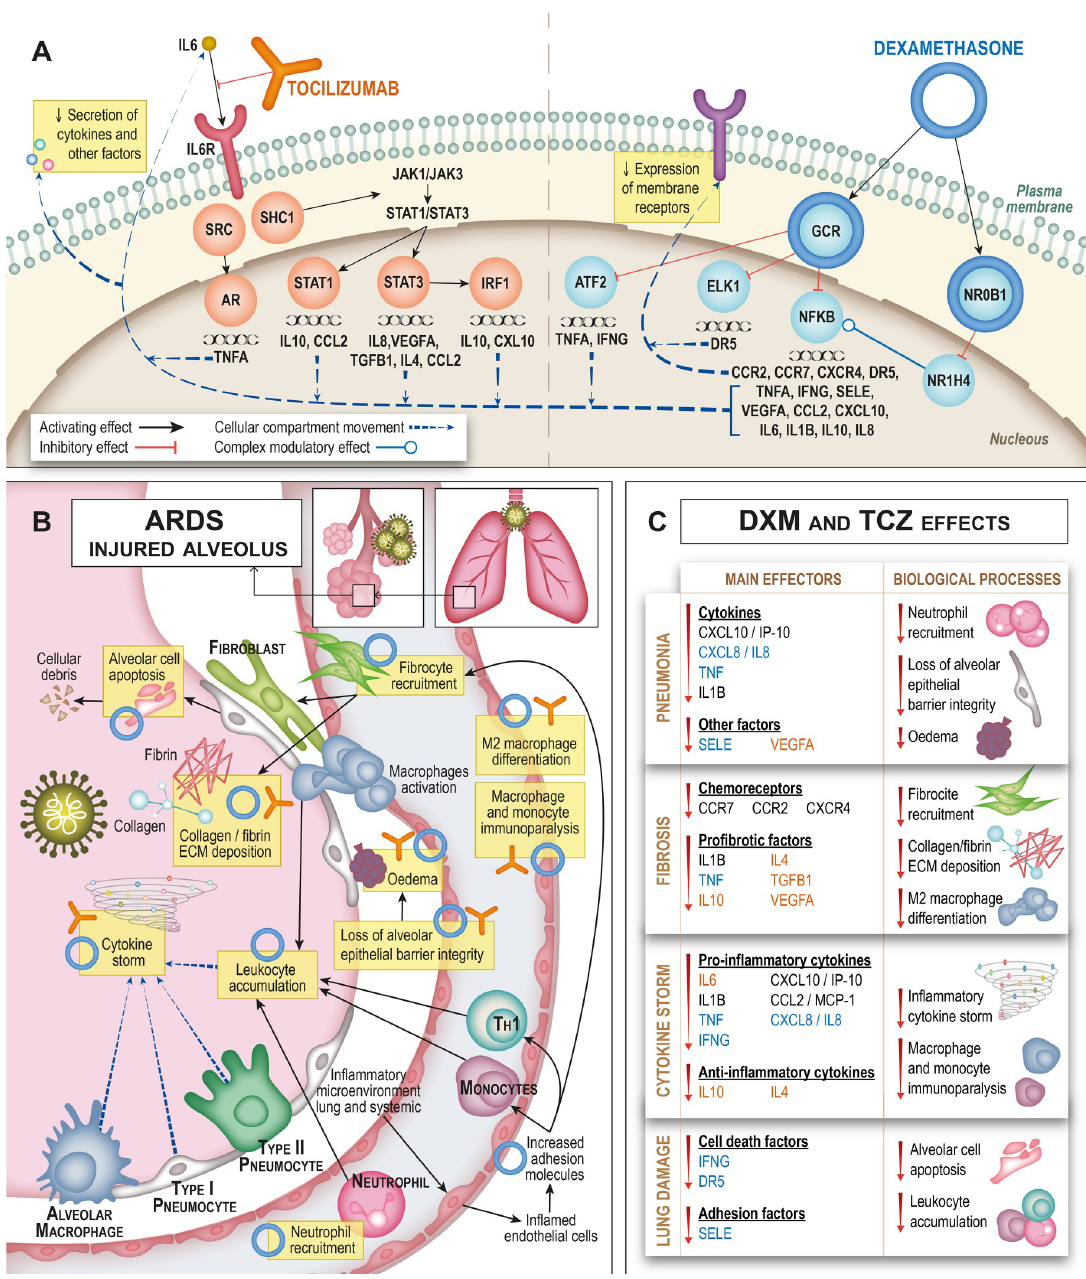
Fig 5. Mechanism of action of dexamethasone and tocilizumab as combined therapy. Consequences of the molecular modulation based on known proteins function and role in COVID-19 evoked ARDS is indicated for biological interpretation. A) shows the intracellular mechanisms of each drug, as predicted by the models; B) shows the known pathological situation in the alveolus in COVID- 19 evoked ARDS, immune components implicated and pathological processes, as well as the drugs can action; C) summarises dexamethasone and tocilizumab effects on specific proteins and pathological processes in COVID-19 evoked ARDS; and classified in each of the studied motives (blue: mainly modulated by dexamethasone, orange: mainly modulated by tocilizumab, black: modulated by both